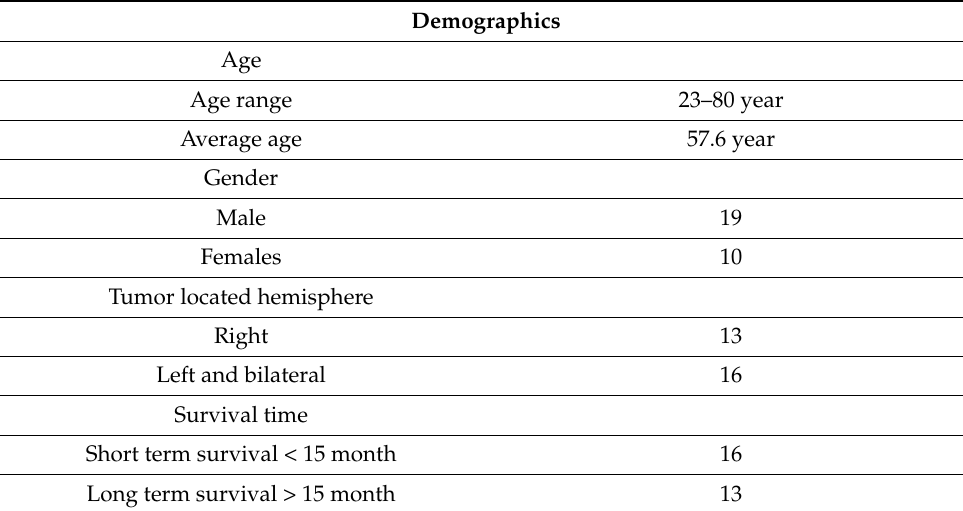
Table 1. Patients ‘characteristics and clinical